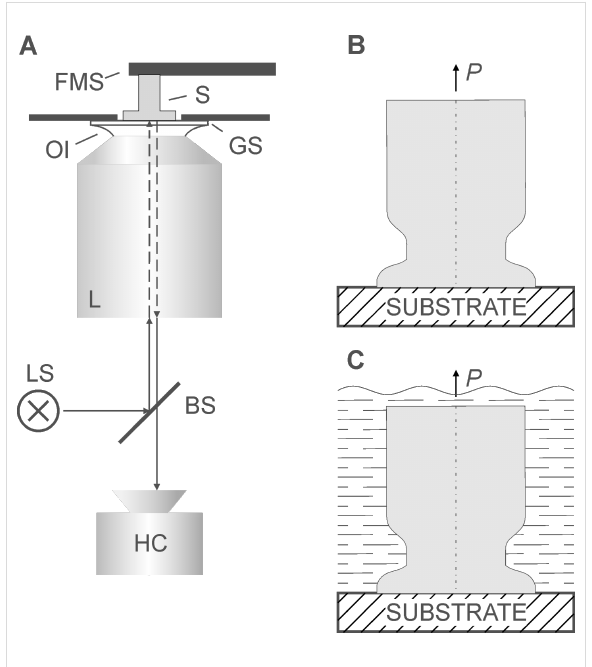
Figure 1: Schematic of the experimental setup (A). FMS, force measuring system; S, sample; GS, glass slide; OI, oil immersion; L, lens; LS, light source; BS, beam splitter; HC, high-speed camera. Individual MSAMS in contact with a substrate under ambient condi- tions (B) and submerged in water (C). P is the applied